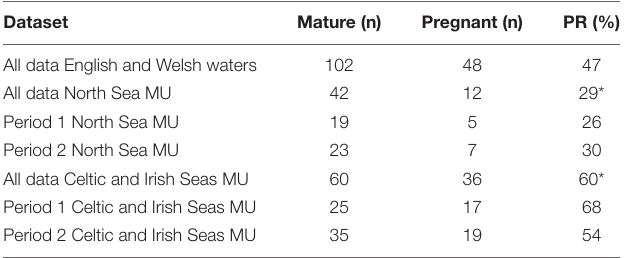
TABLE 5 | Estimated pregnancy rates (PR: percentage pregnant) using all data, and separately for both MUs and time periods. Dataset Mature (n) Pregnant